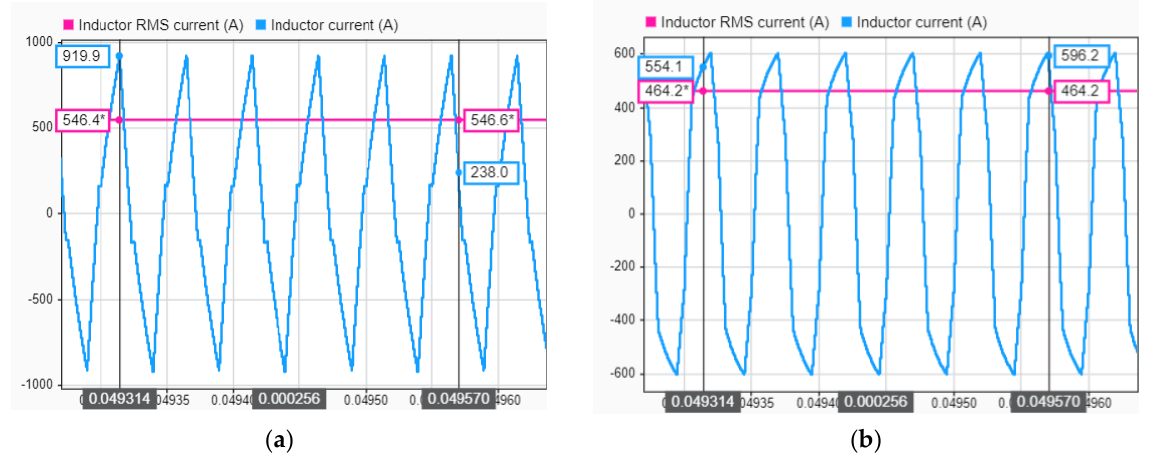
Figure 21 . Peak and RMS currents for 80 kW DAB DC-DC converter: ( a ) operation under optimal TrgPS; ( b ) operation under optimal EPS.